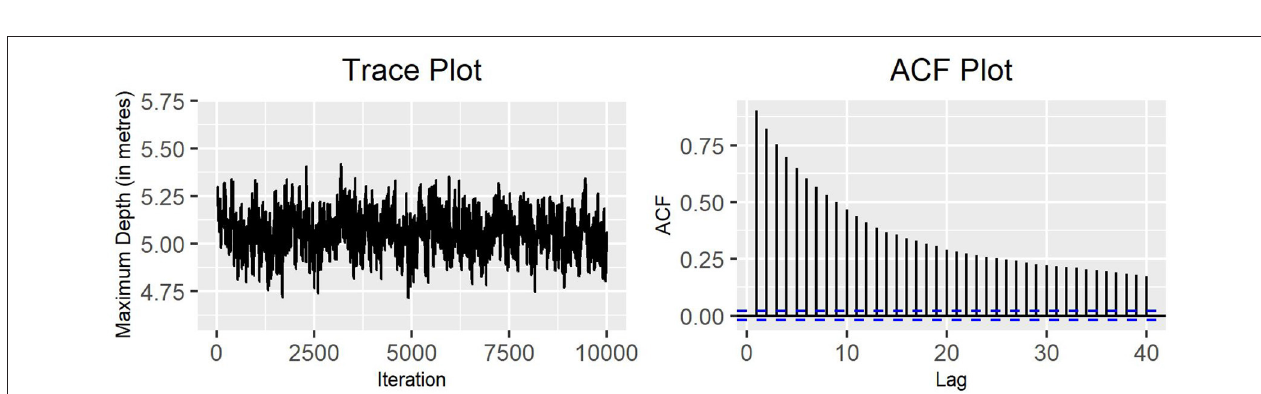
FIGURE 5 | Block-update MH algorithm: trace plot and ACF plot of the standard deviation of the variable maximum depth for production state 2 (10,000 iterations) with blocks arranged by parameter.